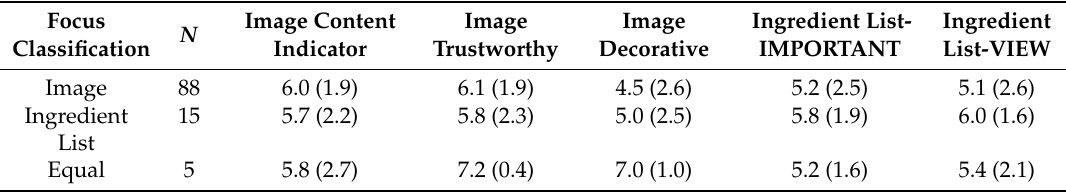
Table 11. Mean (SD) on a 7 point scale per focus classification group (Image, Ingredient List, and Equal) for each item on image and ingredient list.